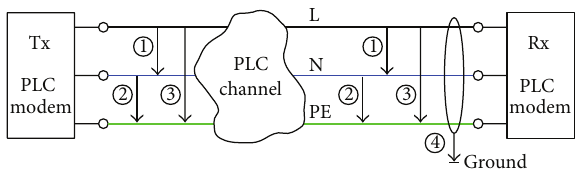
Figure 2: MIMO-PLC channel: different feeding and receiving options.